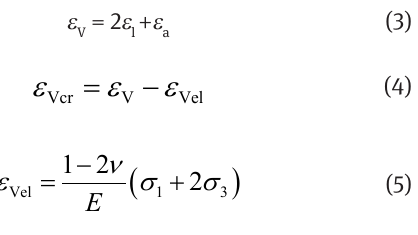
Figure 4: A prepared sample in the beginning of the UCS